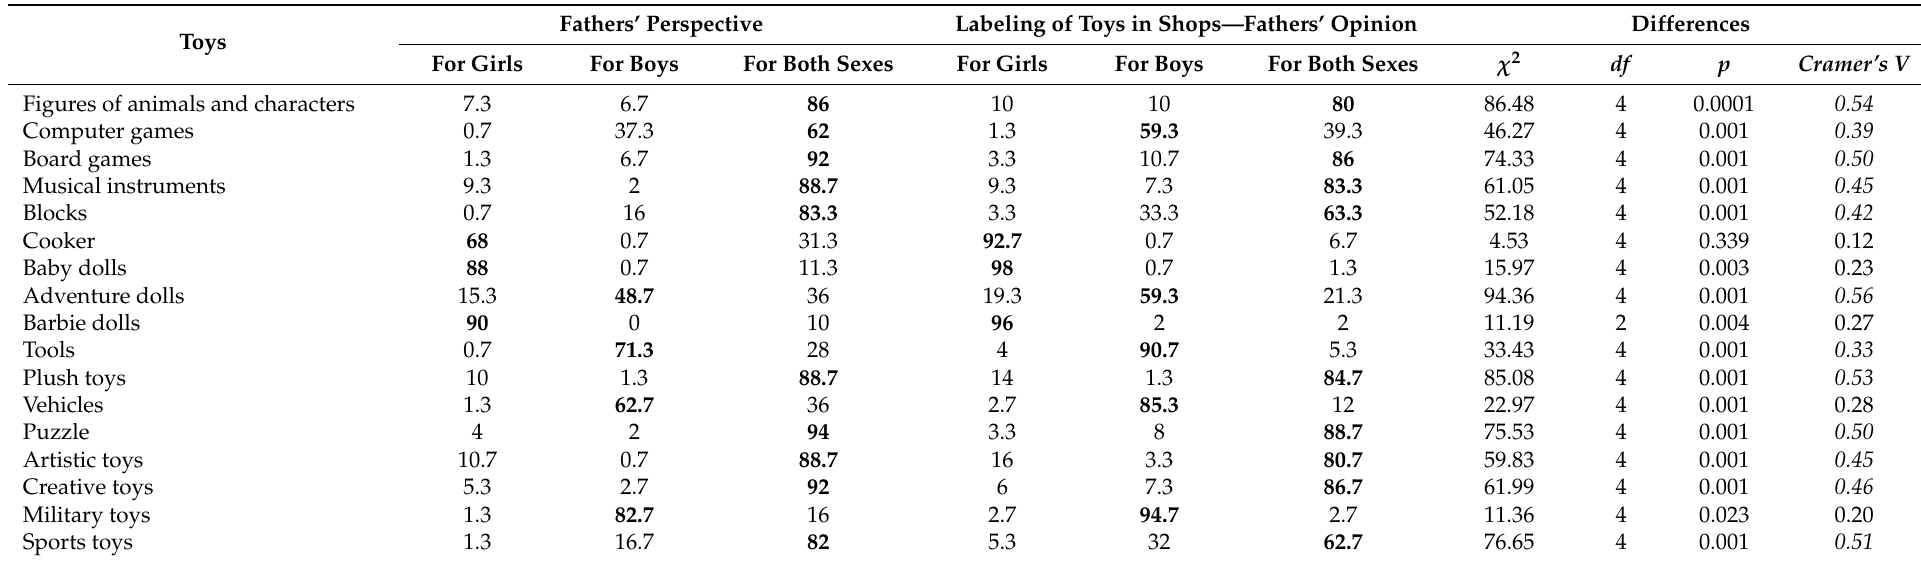
Table 9. Differences between fathers’ perspectives on toys’ appropriateness according to children’s gender and their awareness of labeling of toys in shops according to children’s gender. Fathers’ Perspective Labeling of Toys in Shops—Fathers’ Opinion Toys